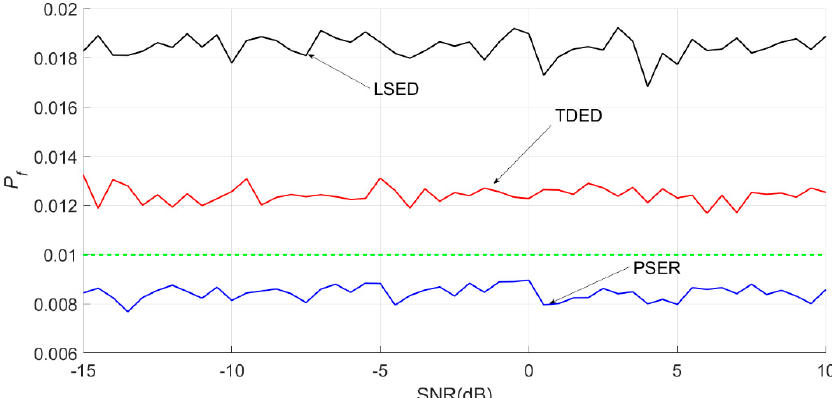
Figure 16. Actual false alarm probabilities obtained by three methods for the Ricker wavelet with local bandwidths of 21–40 Hz.